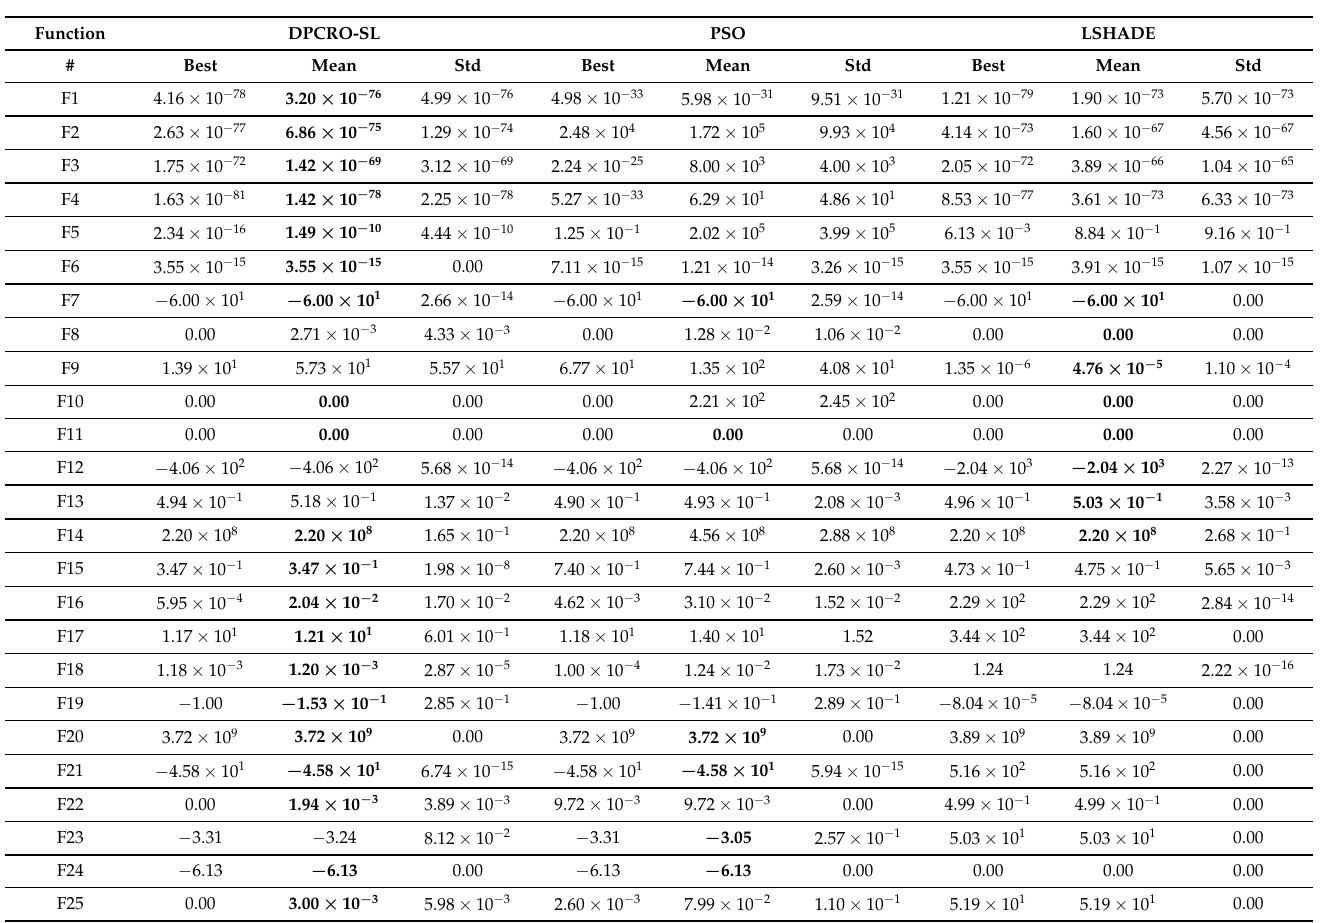
Table 2. Comparison of the DPCRO-SL ensemble with PSO [54] and LSHADE [26]. We indicate the best mean fitness for each algorithm in bold